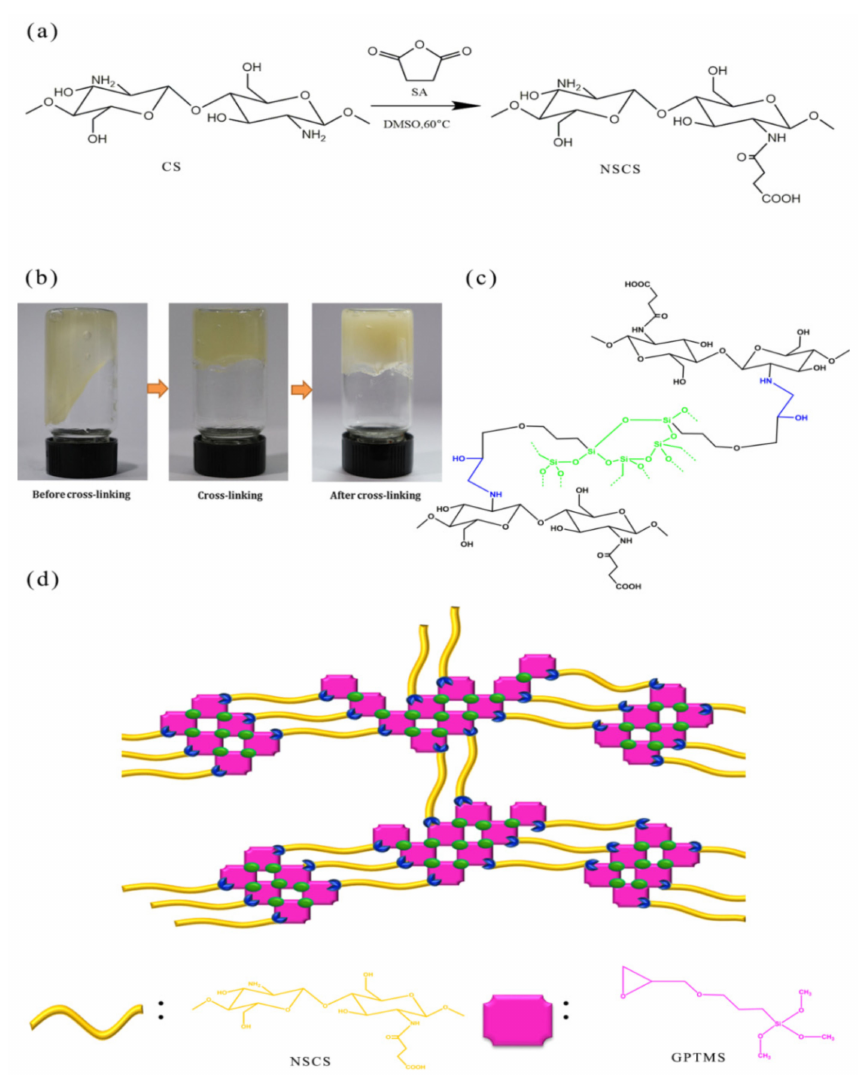
Figure 1. Synthesis scheme of the N -succinyl-chitosan hydrogel (GNCH). ( a ) Synthesis route of N-succinyl-chitosan (NSCS). ( b ) Gelation behavior of cross-linking hydrogel. ( c ) Scheme of cross-linking processes. ( d ) Schematic of the hydrogel